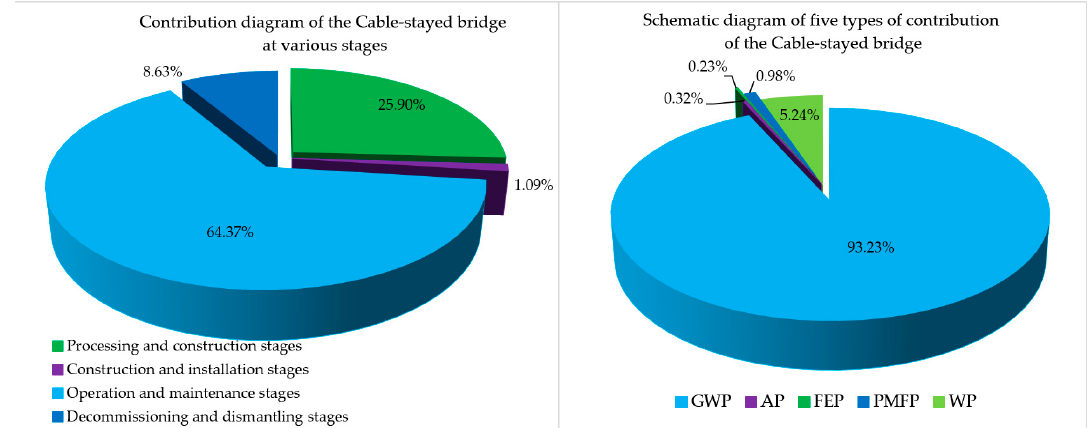
Figure 8. Schematic diagram of the environmental impact contribution of the four phases of the cable-stayed bridge .